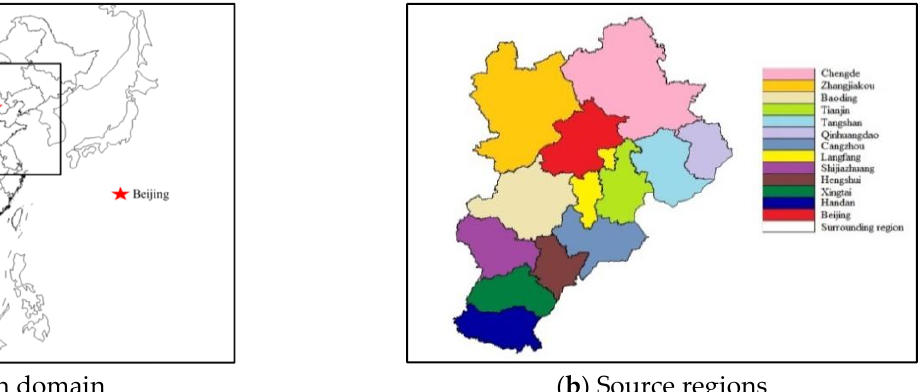
Figure 1. Model simulation domain and source regions.